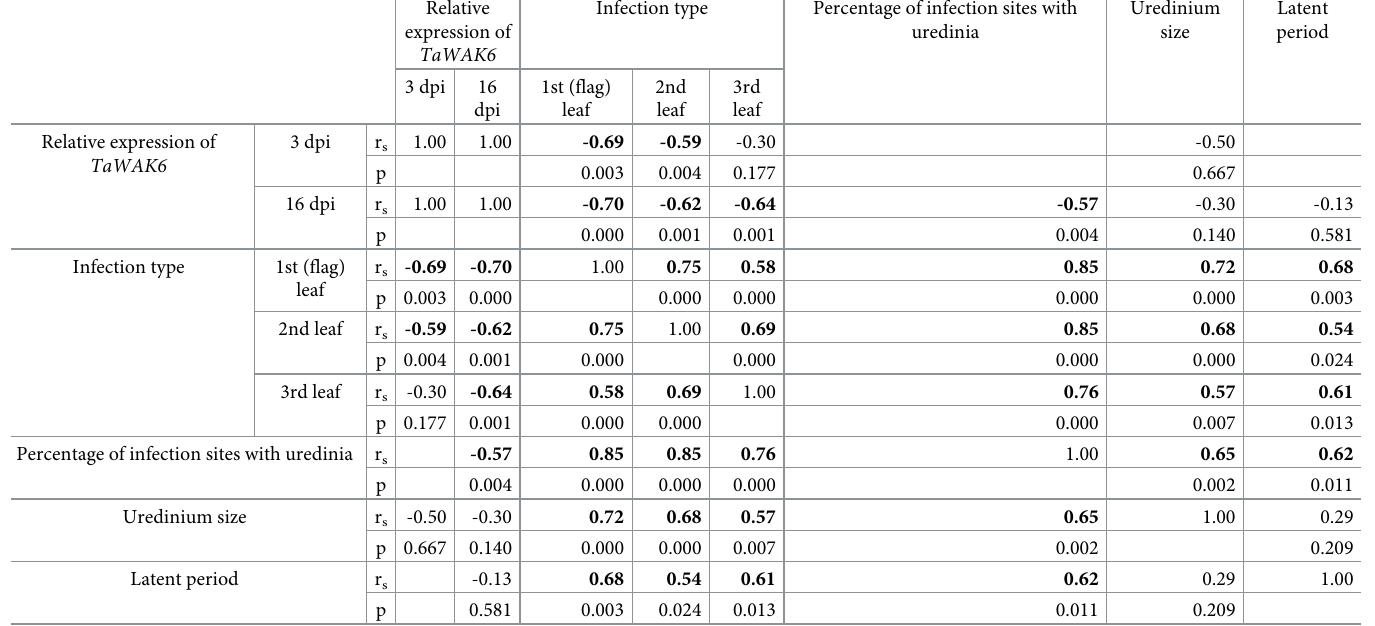
Table 1. Spearman correlation coefficients ( r s ) were calculated for the relative expression of TaWAK6 , the scores of infection types, the percentage of infection sites with uredinia, the uredinium size and the latent period on flag leaves of nontransgenic Kontesa and 7 transgenic lines. The correlation coefficient (STATISTICA 10, StatSoft) was significant at p < 0.05. r values between 0 and |0.29| were defined as a weak correlation, values between |0.3| and |0.69| were defined as medium, and values s between |0.7| and |1| were defined as a strong